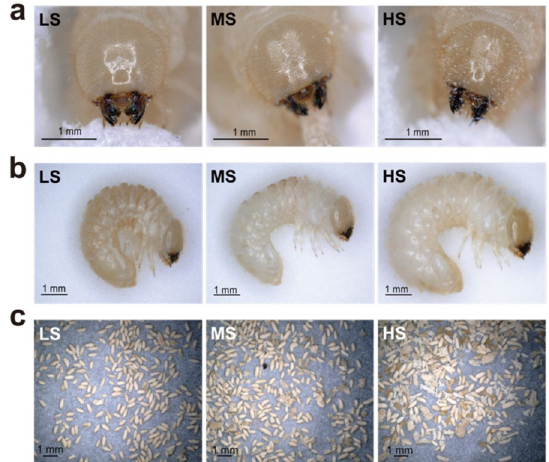
Fig. 3 Morphology of N. hirtum larvae after feeding with artificial diets for 6 months. Facial ( a ), and whole body ( b ), of the larvae and